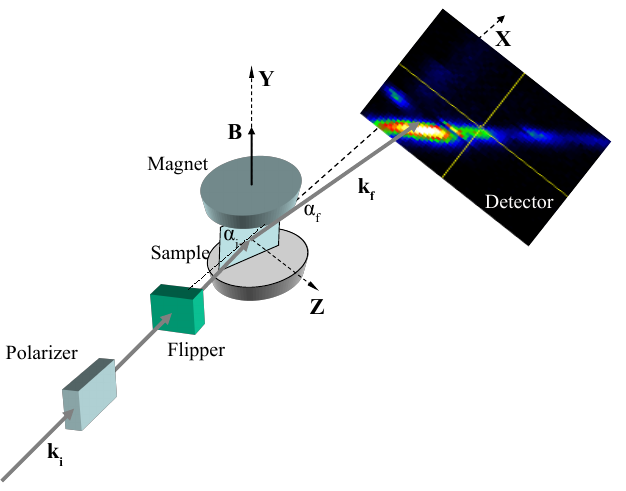
Figure 5. Typical geometry of the polarized neutron reflectometry